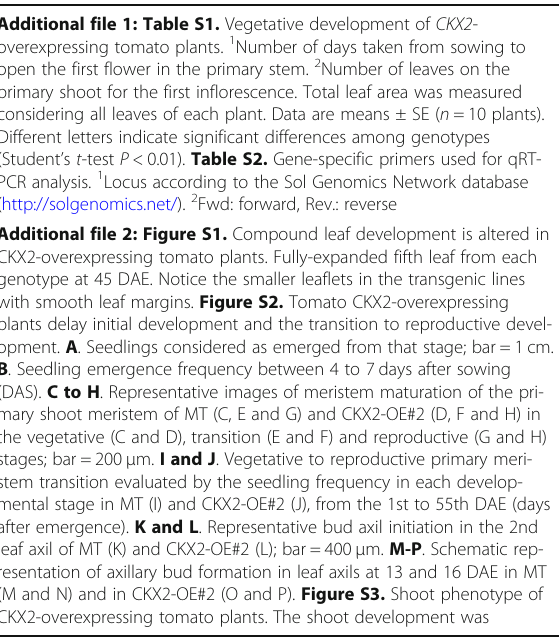
Figure S5. Tomato CKX2-overexpressing plants alter SAM development, vessels organization and root development. Apical shoot ( A and B ), hypo- cotyl ( C and D ) and primary root ( E and F ) were collected from MT (A, C and E) and CKX2-OE#2 (B, D and F) seedlings at 7 DAE. Apical shoots were longitudinally sectioned while hypocotyls and roots were cross- sectioned. Bar = 100 μ m. Figure S6. Reduced ARR5::GUS and DR5::GUS ex- pression in the CKX2-overexpressing tomato plants. The ARR5::GUS (A and B) and DR5::GUS (C and D) expression was evaluated in apical shoots of MT (A and C) and CKX2-OE#2 (B and D) seedlings. Bars= 500 μ m (A, C and D) and 200 μ m (B). Figure S7. Bud length of tomato plants overex- pressing CKX2 upon application of BAP. Shoot phenotype ( A ) and mean bud length ( B ) of BAP-treated and non-treated CKX2-OE#2 compared to MT plants. BAP (10 mM) or mock (0mM BAP) was applied in the leaf axil of MT and CKX2-OE#2 plants at the early vegetative (i.e., 20 DAE for MT and 38 DAE for CKX2-OE#2). The length of the bud in each axil were measured 13days after treatment. Data are means ± SE ( n = 12). Asterisks indicate significant differences between treatments within the same genotype (Mann Whitney test; ** P < 0.01, *** P <0.001). Figure S8. In- creased seed weight of CKX2-overexpressing tomato plants. The weight of one seed was calculated from the weight of pools of 100 seeds. Data are means ± SE ( n = 12). Asterisk indicate significant difference between genotypes (Student ’ s t-test; *** P <